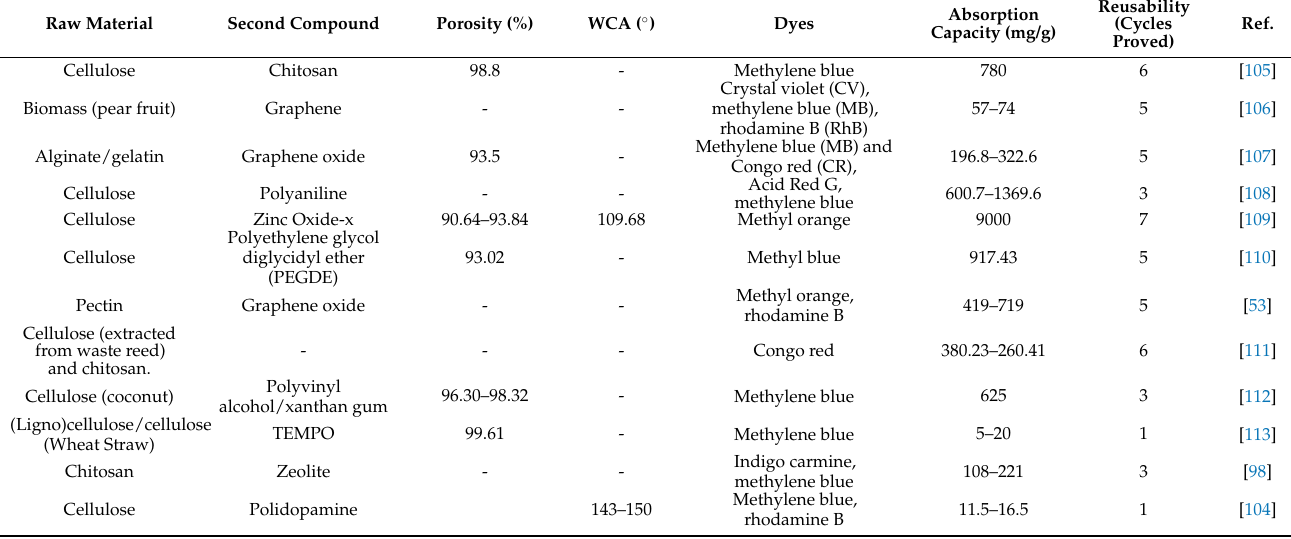
Table 2. Aerogels employed for cationic and anionic dyes